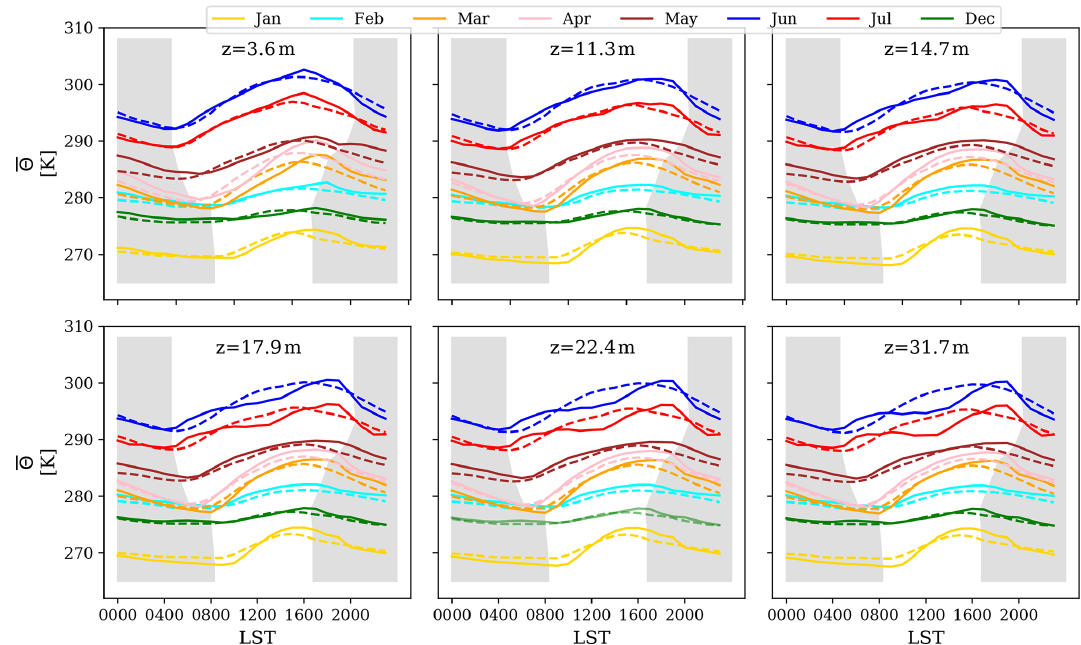
Figure 4. Comparison between the observed (BUBBLE) versus simulated (VCWG) values of potential temperature. The hourly means are shown, and nighttime is indicated by shaded regions. Solid line: model, dashed line: observation. Times are in local standard time (LST).